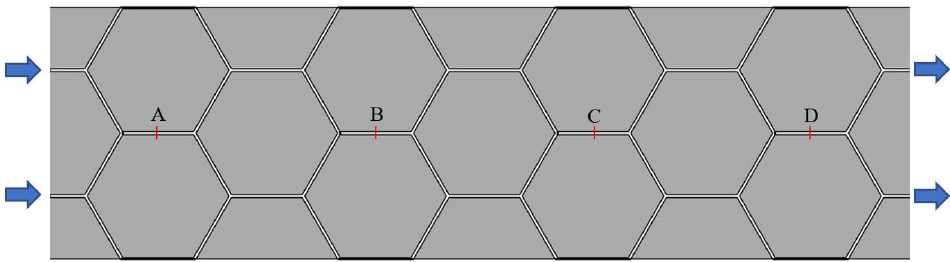
Figure 1. Calculation area and cross-sections for measuring pressure